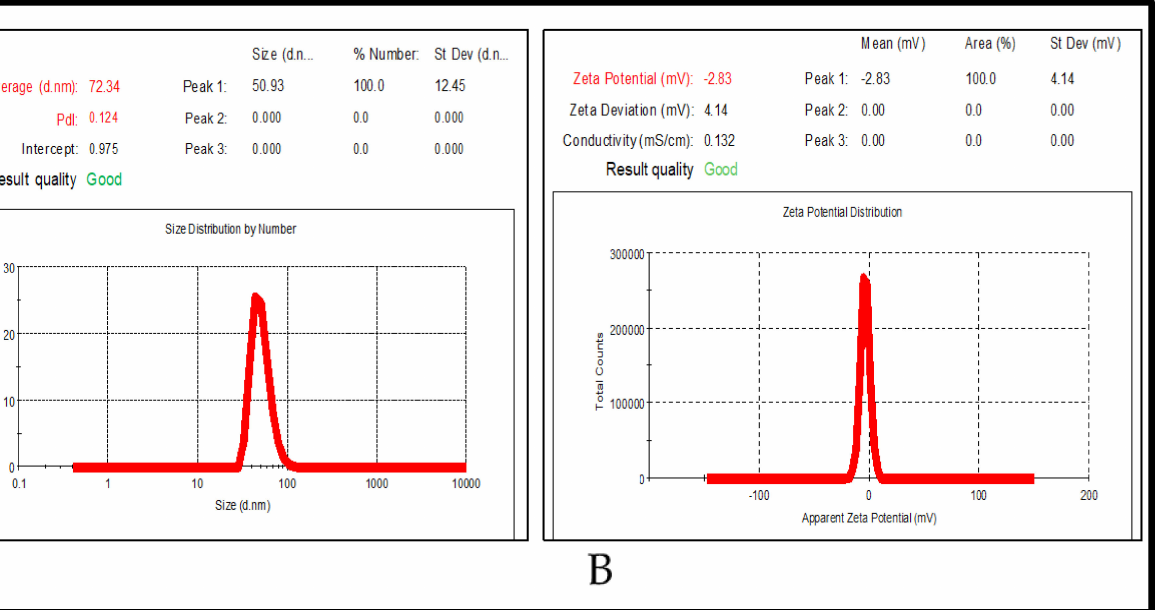
Figure 5. Particle size, polydispersity index ( A ) (PDI), and zeta potential ( B ) of